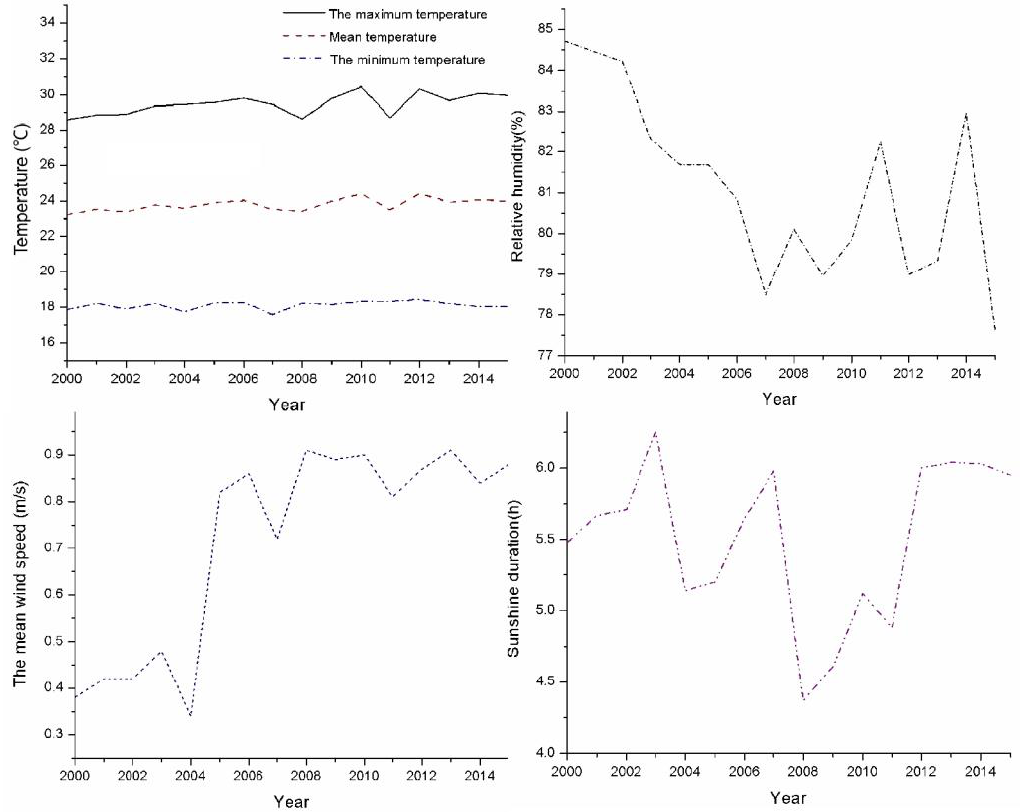
Figure 2. Trend of meteorological variables at Mengla Meteorological Station from 2000 to 2015.